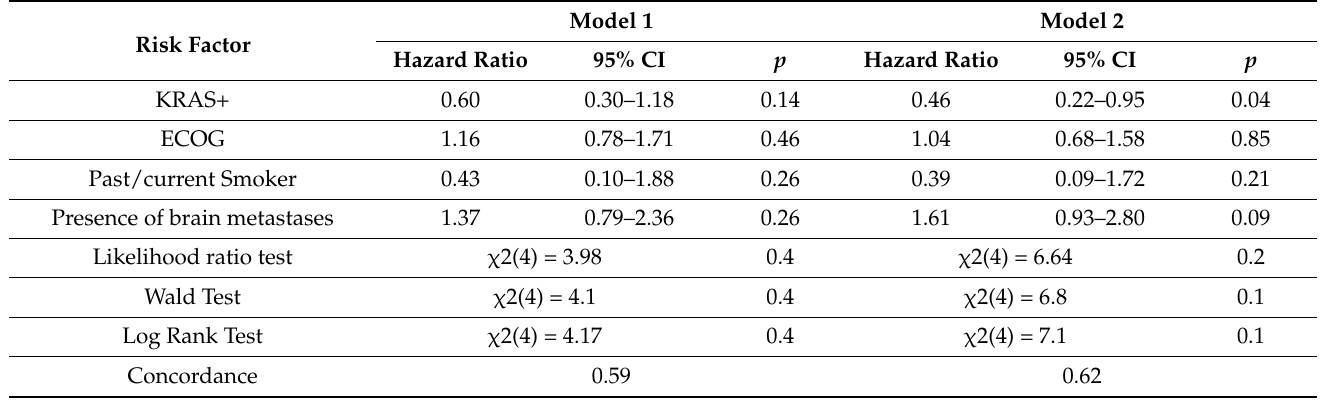
Table 4. Description of Cox Proportional Hazard Models (PFS) for KRAS+/ − . Abbreviations: CI, confidence interval; KRAS+, patients with any mutation in KRAS gene; p , p value.